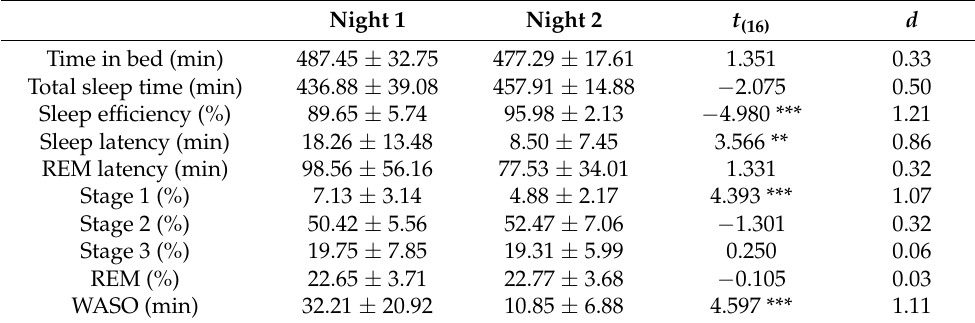
Table 2. Polygraphic sleep structure on Night 1 and Night